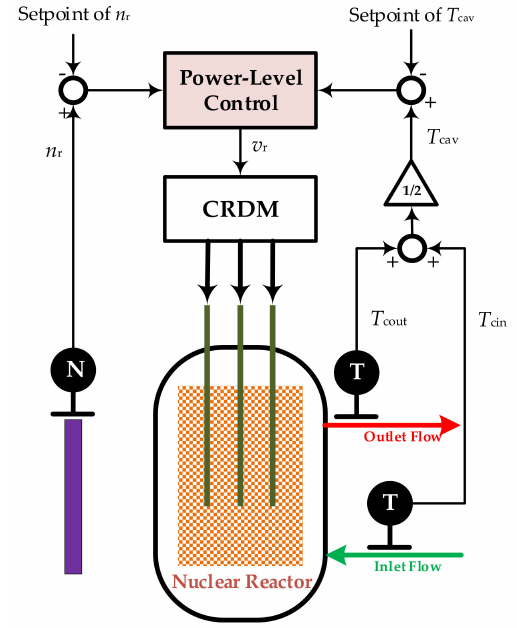
Figure 1. Schematic view of nuclear reactor power-level control, nr: normalized neutron flux, T cout : primary coolant temperature at the reactor outlet, T cin : primary coolant temperature at the reactor inlet, T cav : average primary coolant temperature, v r : control rod speed signal, CRDM: control rod driving